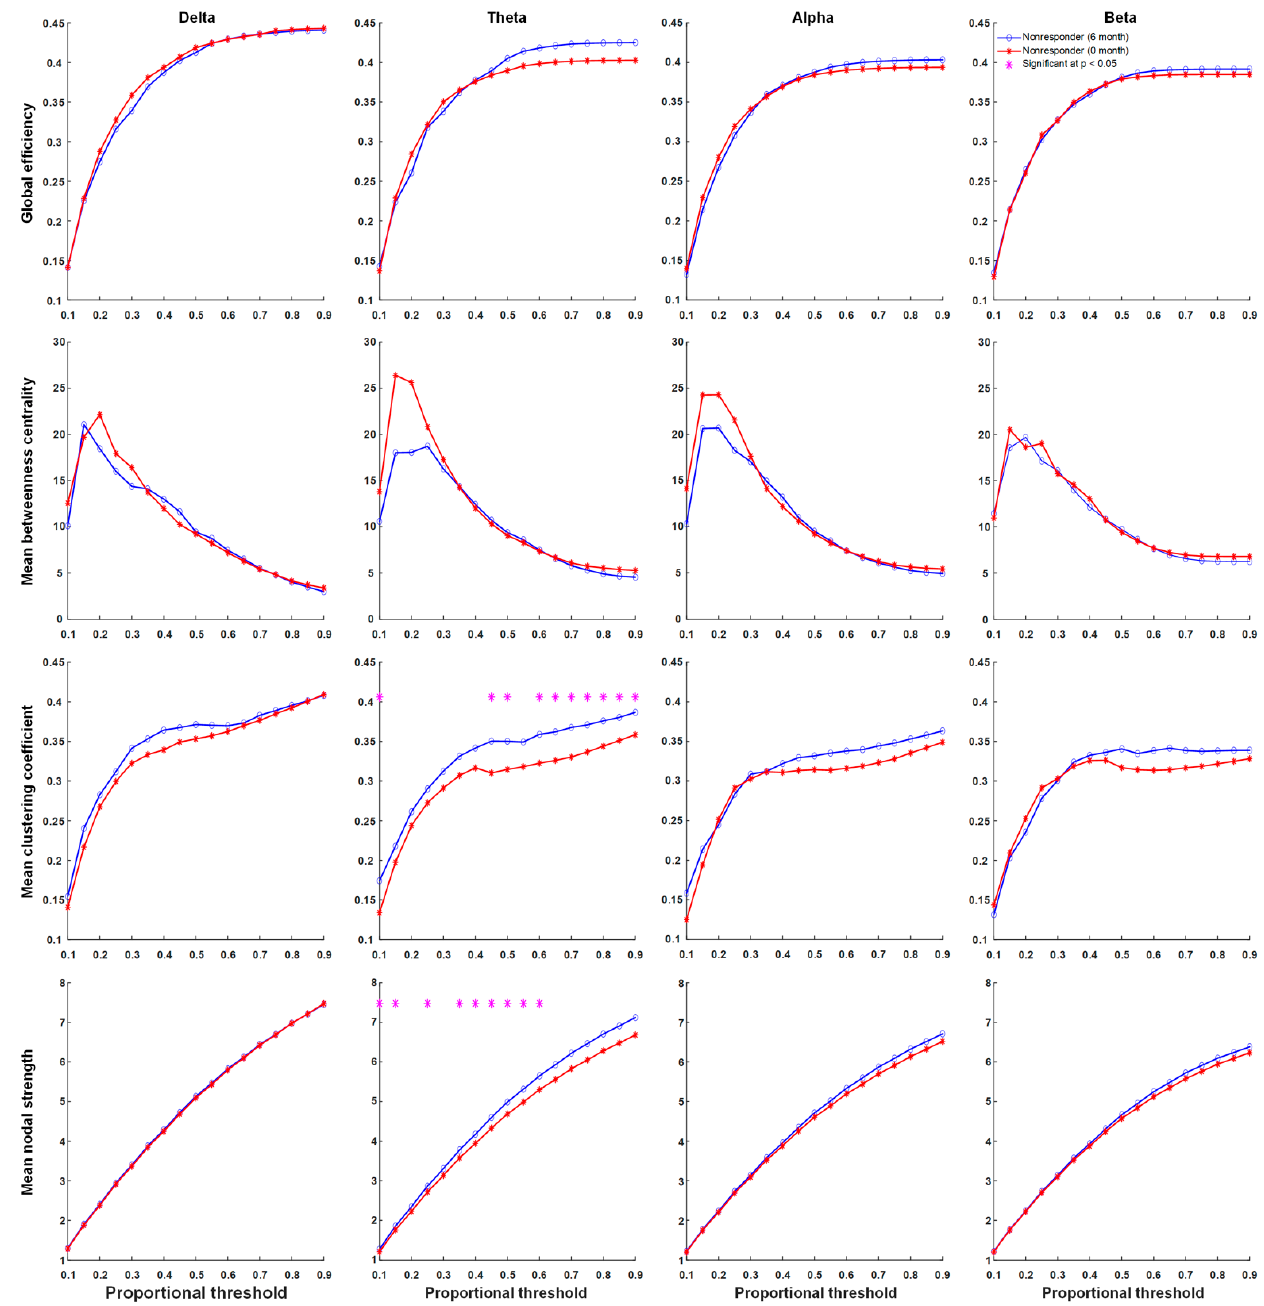
Figure 4. Graph theory-based analyses between before KDT and after six months of KDT for non-responders show global efficiency, mean clustering coefficient, mean nodal strength, and mean betweenness centrality in delta, theta, alpha, and beta frequency bands. The results revealed significant increases in the network properties of mean clustering coefficient and mean nodal strength in the theta frequency band after six months of KDT. Asterisks denote statistically significant differences ( p < 0.05). (KDT: ketogenic diet therapy.)